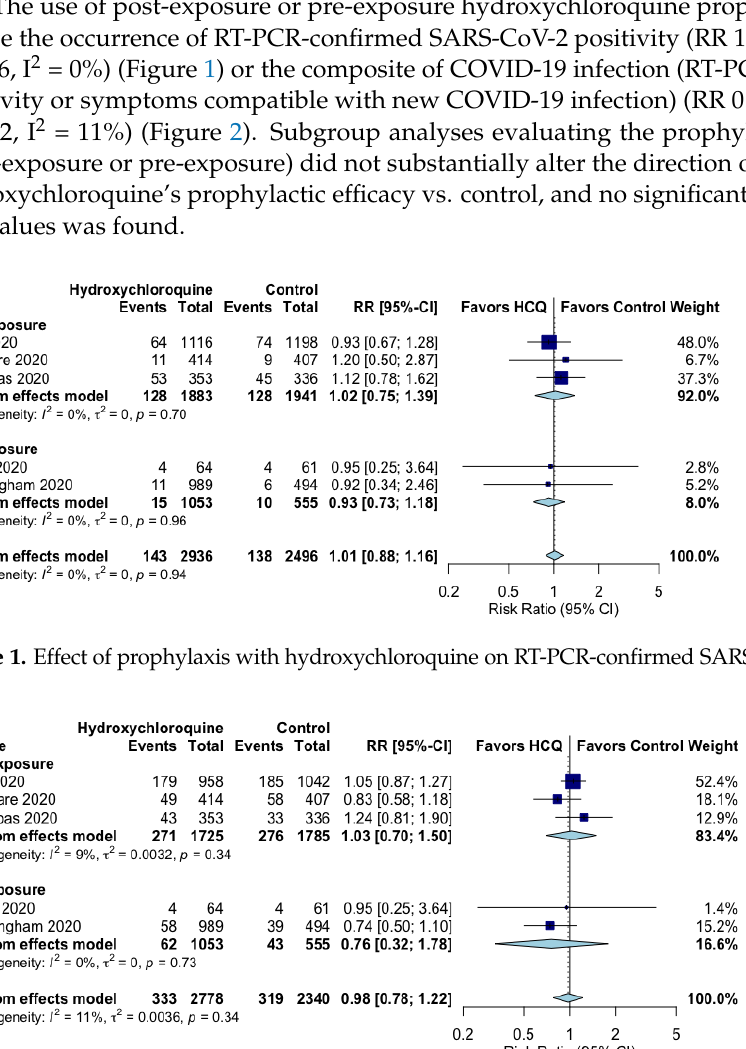
Figure 2. Effect of prophylaxis with hydroxychloroquine on COVID-19 infection (either RT-PCR SARS-Cov-2 positivity or symptoms compatible with COVID-19).